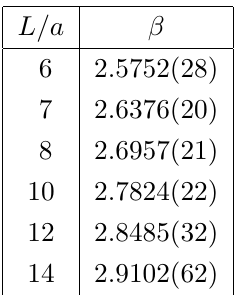
Table 7 . Values of (cid:12) = 4 =g 2 as a function of the linear extent of the system in units of the lattice 0 spacing, at (cid:12)xed g 2 ( L ) = 4 : 765, reproduced from ref. [31, table 3].